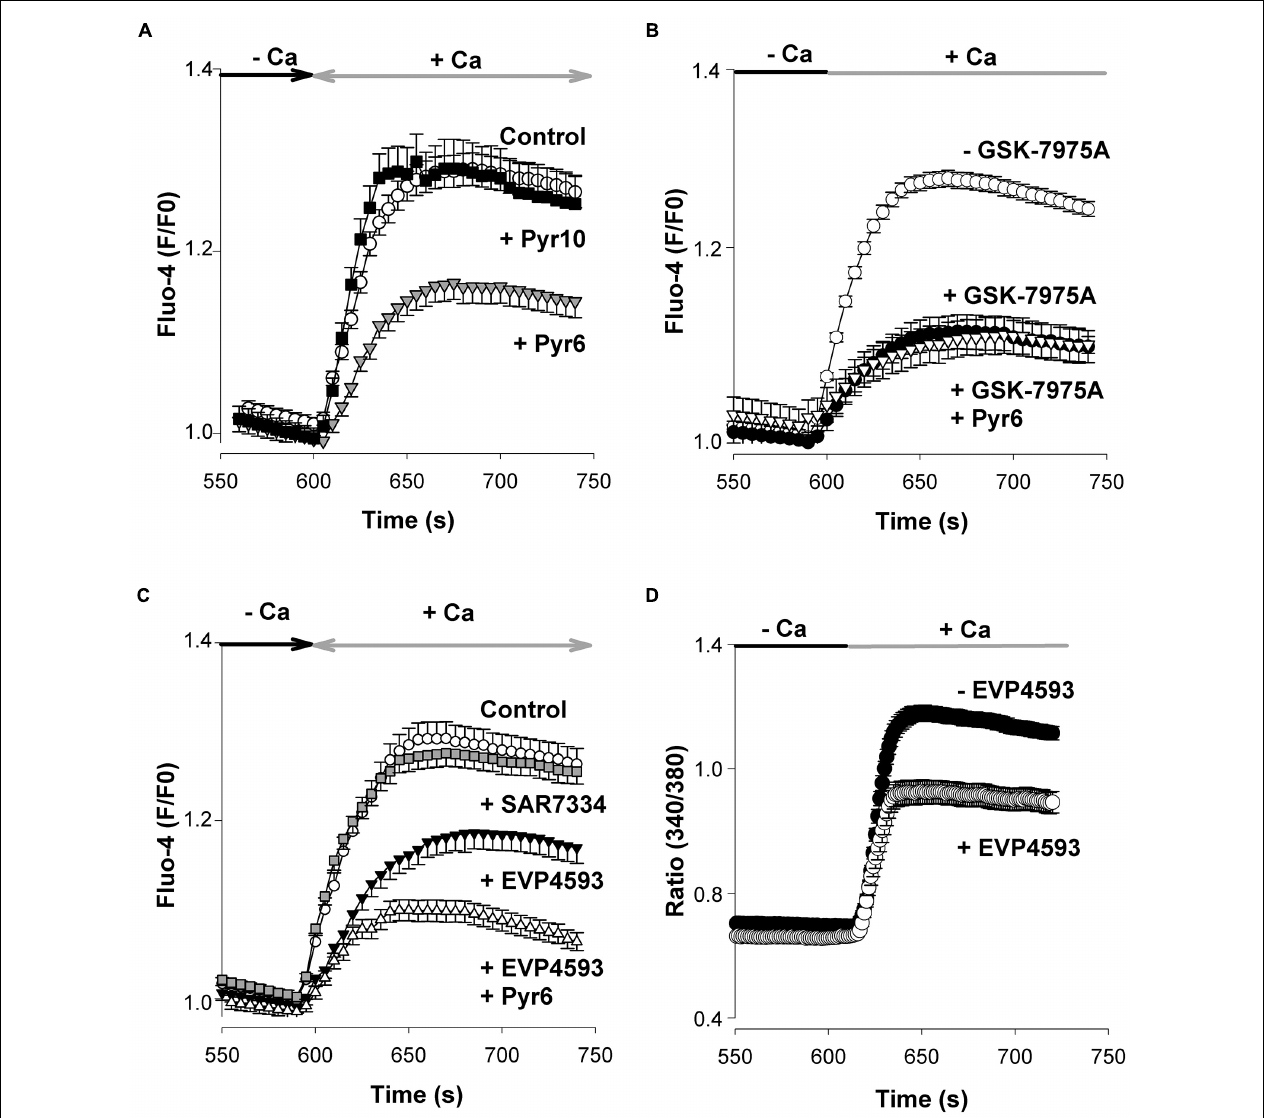
FIGURE 3 | Pyr6, GSK-7975A, and EVP4593 inhibit SOCE but not SAR7334. (A) In these experiments Fluo-4 loaded cells were processed as in Figure 2 . Pyr6 (gray triangles, n = 113 cells) or Pyr10 (filled squares, n = 96 cells; 1 µ M) was added to the saline recording medium at time + 60 s and remained present till the end of the experiment. Open circles: untreated (control) cells ( n = 107). (B) Same experiments as in A except 5 µ M GSK-7975A (filled circles, n = 118 cells), or GSK-7975A (5 µ M) + Pyr6 (1 µ M, open triangles, n = 73 cells, data from 2 cell cultures) were added to the saline at time + 60 s prior to the application of Tg and remained present throughout the recording. Open circles: untreated (control) cells ( n = 63 cells). (C) Same protocol as in A except SAR7334 (1 µ M, gray squares, n = 134 cells), EVP4593 (1 µ M, filled triangles, n = 112 cells), or EVP4593 (1 µ M) + Pyr6 (1 µ M; open triangles, n = 62 cells), were added at time + 60 s. Open circles: untreated (control) cells ( n = 117 cells). The joint application of EVP4593 (1 µ M) + Pyr6 (1 µ M) was tested on two cell cultures. None of the substance tested affected the Tg-evoked Ca 2 + response (not shown). (D) EVP4593 depressed SOCE in RBL-2H3 cells. The effect of EVP4593 on native Orai channels from RBL-2H3 was tested by means of Fura-2 Ca 2 + imaging experiments according to experimental procedures already described (Schleifer et al., 2012). EVP4593 (300 nM, open circles, n = 41 cells) was added to the saline at time + 60 s prior to the application of Tg (200 nM) and remained present throughout the recording. Filled circles: Control (EVP4593 untreated) cells ( n = 52). EVP4593 significantly reduced the peak amplitude of the native SOCE ( p < 0.001, Student’s t -test). The graphs (A–D) show the last 200 s of the recording. Mean ±